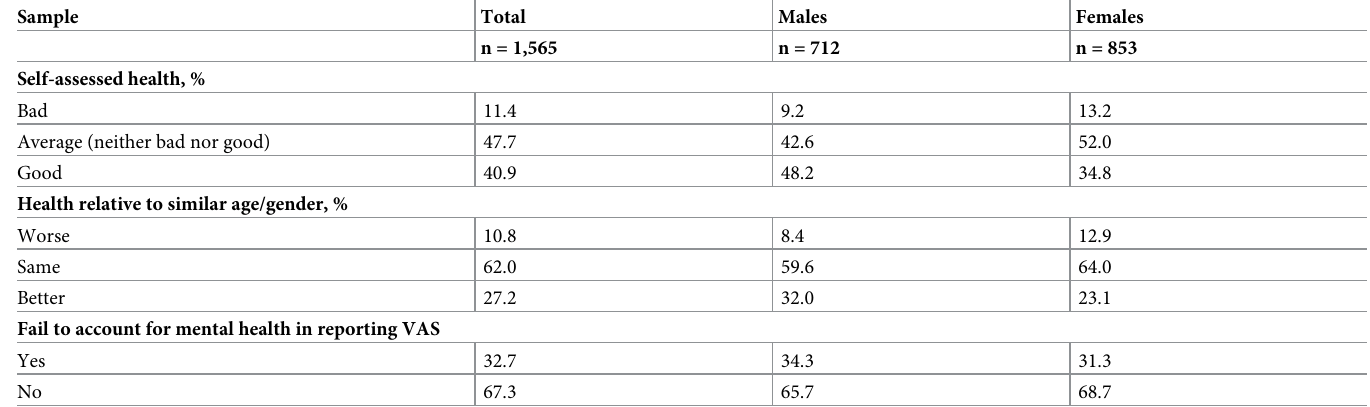
respondents. The gender pattern observed for EQ-VAS is replicated over all five EQ–5D dimen- sions, though it is noteworthy that the ranking order of the difficulties experienced in each dimension is the same for men and women: that is, self-care, mobility, usual activities, pain and anxiety; from least to most problematic. The mean EQ-5D index is 0.84 (SD = 0.23) with males (0.87) reporting significantly higher scores than females (0.81). The means differed significantly (p < 0.0001) across all socio-demographic and health-related variables. Lower index scores were observed in higher age groups, lower education groups, and among the poor. Participants who were divorced or (particularly) widowed had the lowest index score compared to other marital categories. Similarly, people suffering from chronic diseases, feeling blue mood/anxiety or with any other health issues had significantly lower utility scores compared with their coun- terparts (p < 0.0001). These results are all in line with those for the EQ-VAS. problems (level 2 or 3) in at least one EQ–5D dimension, with the largest proportion of respondents (37.4%) reporting problems in the anxiety/depression component (31.04% male; 42.79% female). For comparison, 32.2% of respondents report pain/discomfort, 25.9%